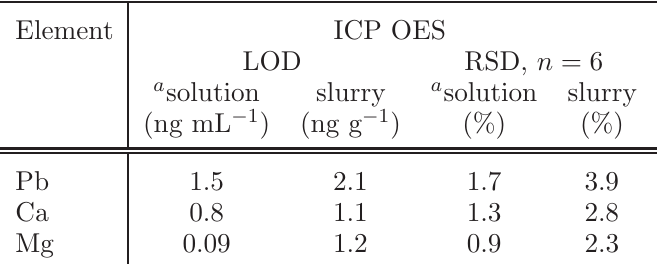
Table 4 Analytical figures of